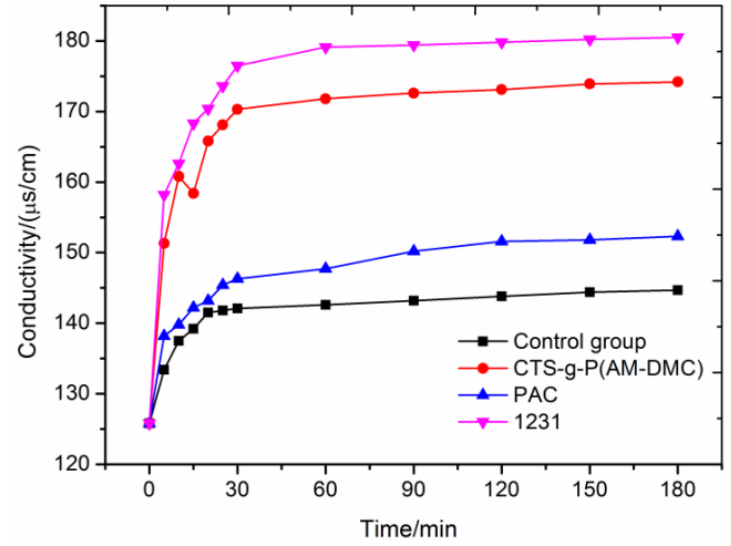
Figure 9. Conductivity of the Salmonella suspension as a function of time.